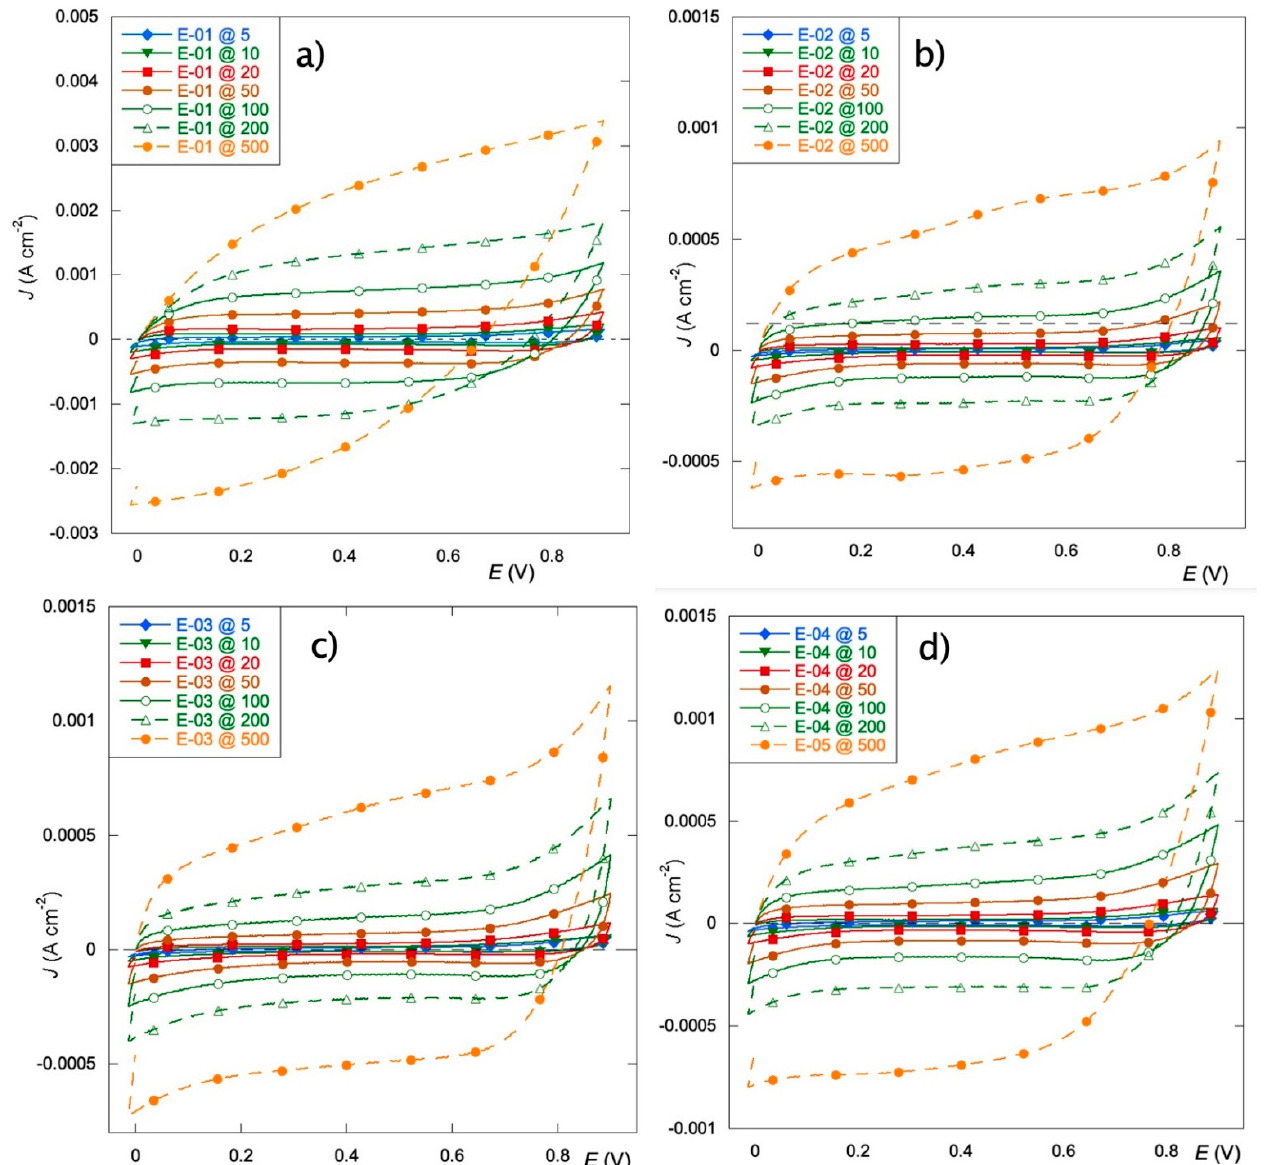
Figure 3. Cyclic voltammetries at scan rates in the range 5–500 mV s − 1 in Na 2 SO 4 0.1 mol L − 1 for: E-01 ( a ), E-02 ( b ), E-03 ( c ), E-04 ( d ).